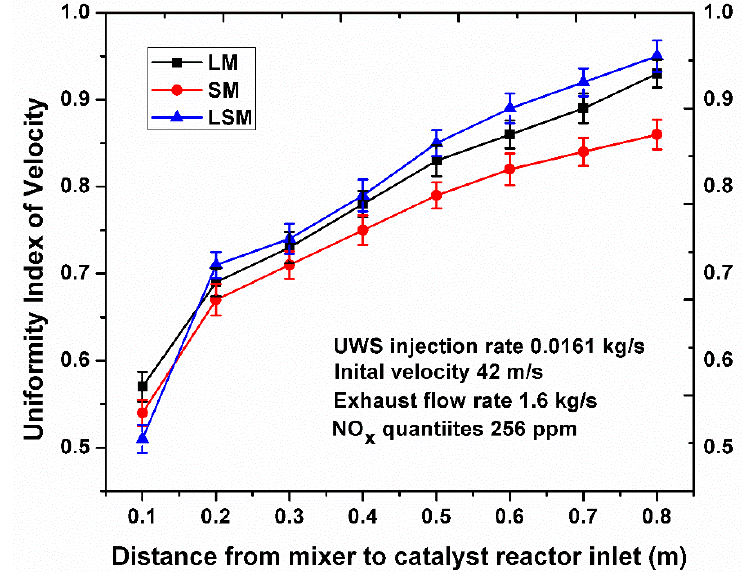
Figure 5. Distribution of velocity uniformity.